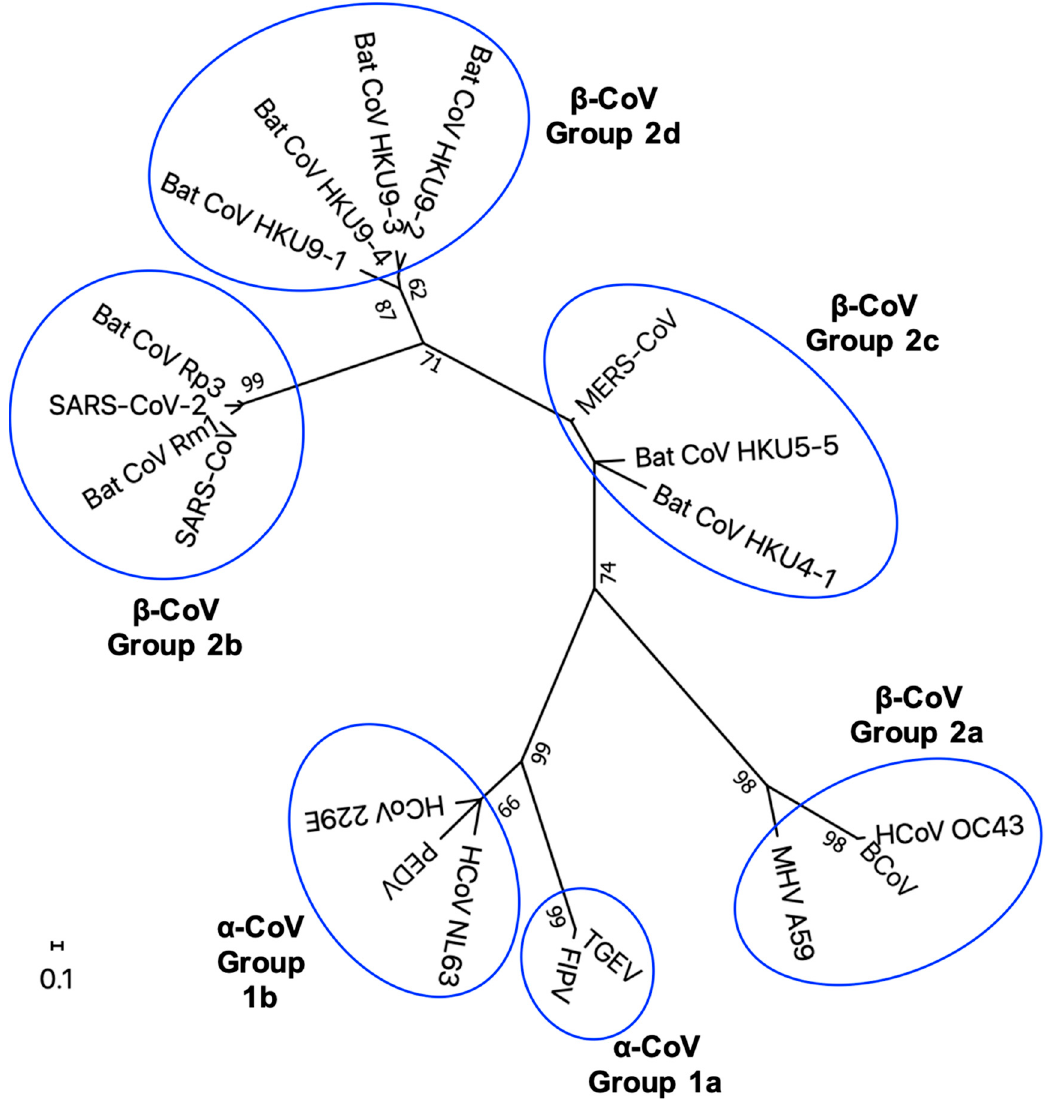
Figure 1. Phylogenetic tree of CoV nsp1. Unrooted maximum likelihood phylogeny of 17 publicly available amino acid sequences of CoV nsp1 is shown. a-CoVs and b-CoVs are divided into groups 1a and 1b and groups 2a, 2b, 2c, and 2d respectively, and the tree, based on 100 amino acid residues, was designed using MEGA X [82]. All positions containing gaps and missing data were eliminated. Bootstrap values (1000 replicates) above 60 are shown. The scale bar indicates the estimated number of substitutions per 10 amino acids. The virus strains used in the phylogenetic analysis are as follows: SARS-CoV-2 (accession no.: MN908947.3); SARS-CoV (Urbani strain, accession no.: AY278741.1); Bat